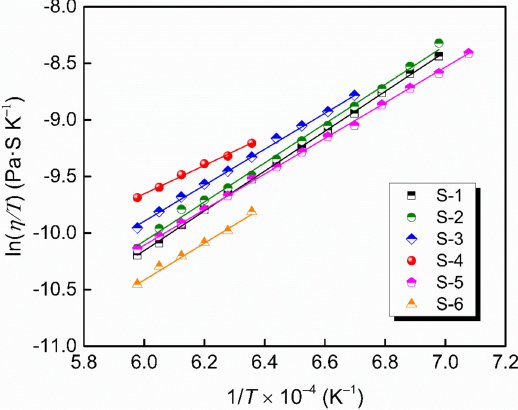
Figure 8. The natural logarithm of η / T as a function of 1/ T